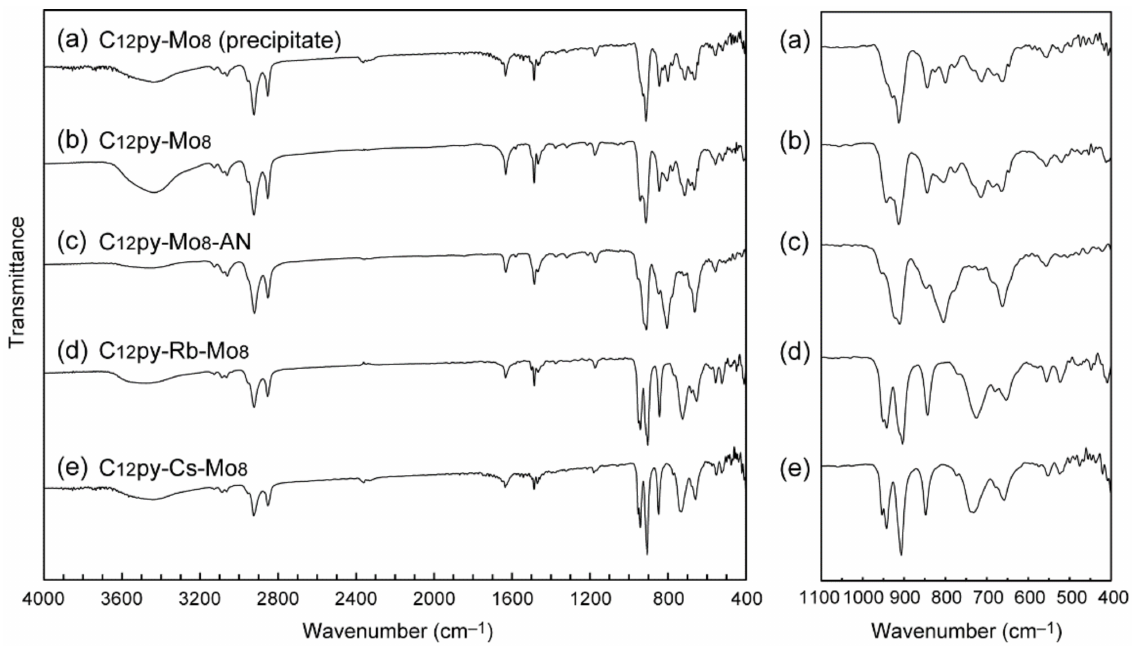
Figure 1. IR spectra of C 12 py-Mo 8 and related hybrid crystals: ( a ) C 12 py-Mo 8 precipitate; ( b ) C 12 py- Mo 8 after recrystallization; ( c ) C 12 py-Mo 8 -AN; ( d ) C 12 py-Rb-Mo 8 ; ( e ) C 12 py-Cs-Mo 8 .